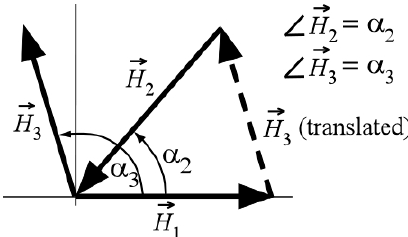
Figure 4. Vector diagram of UMZV DRF shaper.